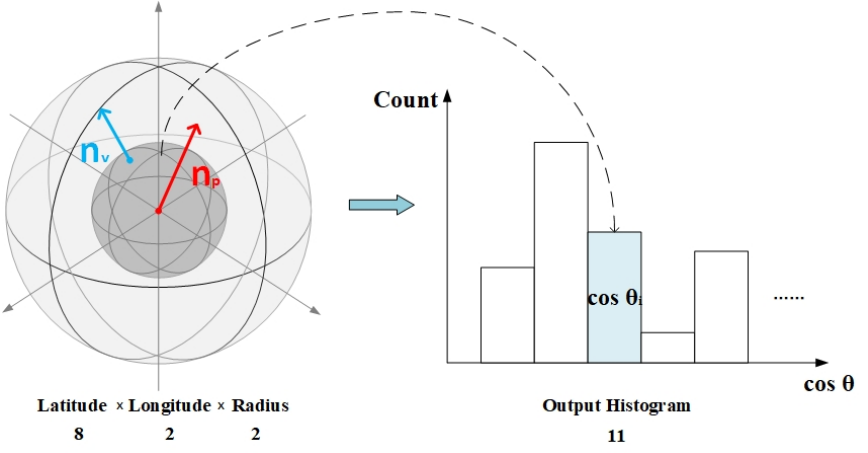
Figure 3. Generation principle of SHOT.